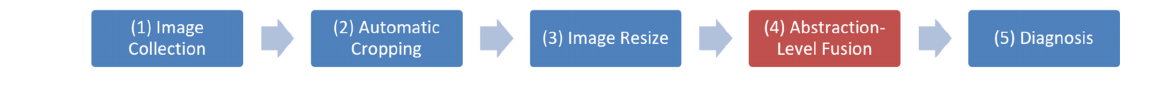
FIGURE 2 | System overview. Red: focus of work.